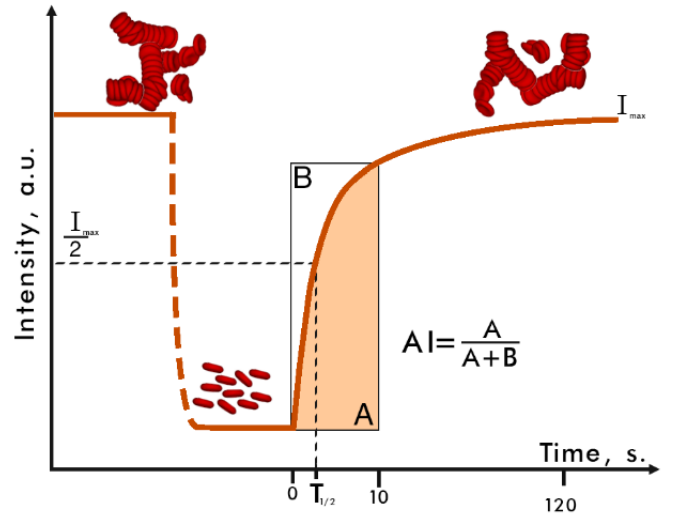
Figure 1. The kinetics of the RheoScan aggregometer output signal (intensity of light scattered forward as a function of time). The meaning of T 1/2 and AI is indicated. ‘A’ is the area below the intensity curve inside the rectangle; ‘B’ is the area above the intensity curve inside the rectangle.